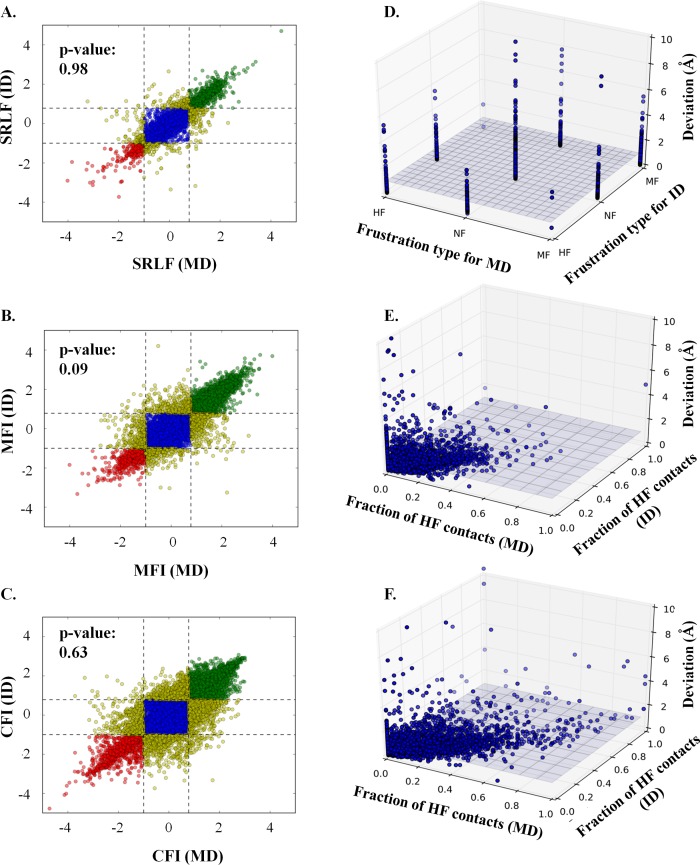
Frustration index (FI) distribution.Scatter plot of the distribution of (A) single residue level frustration (SRLF) (two-sample KS test, p-value: 0.98), (B) mutational frustration index (MFI) (two-sample KS-test, p-value: 0.09) and, (C) configurational frustration index (CFI) (two-sample KS test, p-value: 0.63) of residues for all the domain pairs. The X-axis represents the frustration index for MD and the Y-axis represents the frustration index for ID. Residues which are minimally frustrated (MF) in both MD and ID are represented as green filled circles, residues which are neutrally frustrated (NF) in both MD and ID are represented as blue filled circles and residues which are highly frustrated (HF) in both MD and ID are represented as red filled circles. The residues showing differences in the type of frustration between MD and ID are represented as yellow filled circles. The dotted lines represent the cut-off used for the definition of frustration index (MF: FI ≥ 0.78; HF: FI ≤ -1 and NF: -1 < FI < 0.78). 3-D plot of the distribution of (D) frustration type, (E) fraction of highly mutationally frustrated contacts of each residue and, (F) fraction of highly configurationally frustrated contacts of each residue and the structural deviation observed between the corresponding C-alphas on superposition. A plane (grey color) is drawn at the deviation value of 1Å.